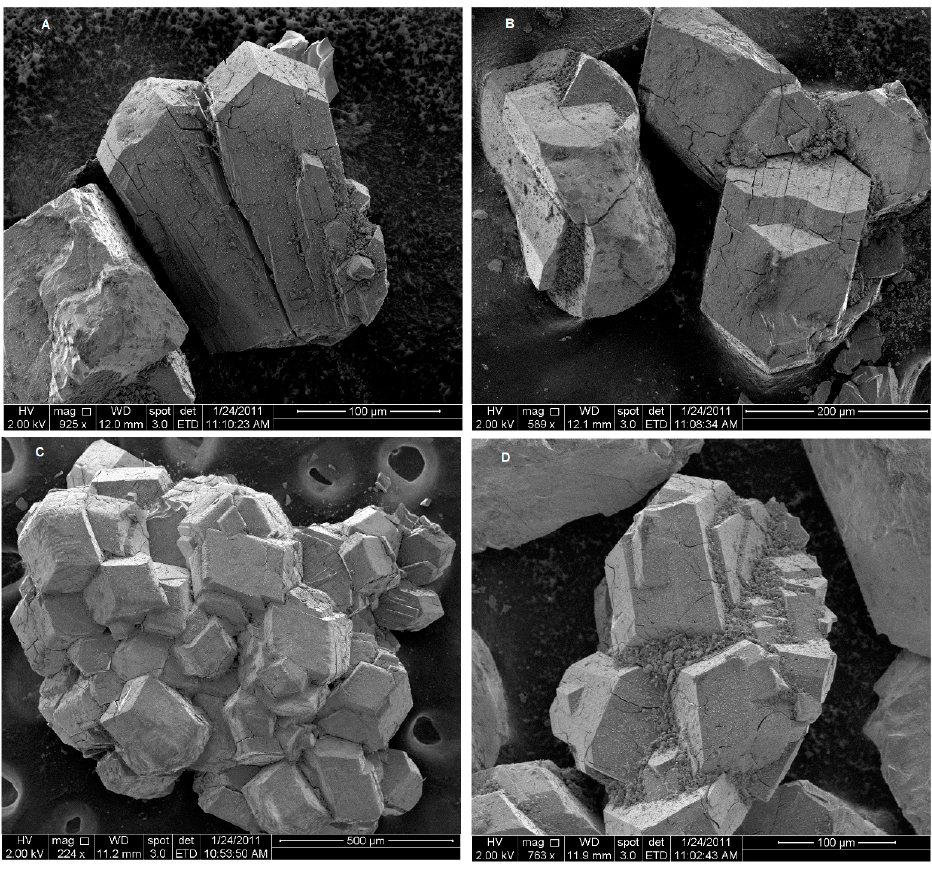
Figure 2. Scanning electron micrographs showing: ( A ) and ( B ) radial aggregates of phillipsite; ( C ) and ( D ) rhombohedral chabazite crystal aggregates with penetration twinning.